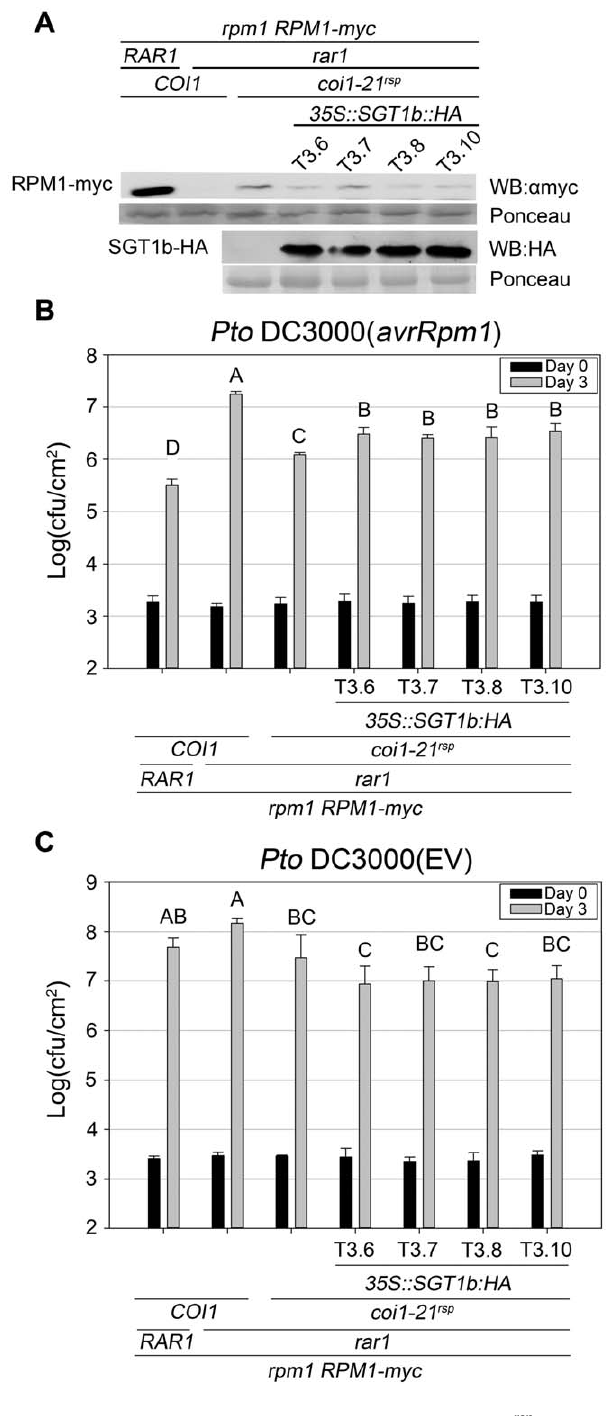
Figure 6. SGT1b over-expression antagonizes coi1 rsp -depen- dent RPM1 accumulation and RPM1 -mediated disease resis- tance in rar1 . (A) Western blot analysis of RPM1-myc and SGT1b-HA protein levels in indicated genotypes. RuBisCo levels stained by Ponceau S serve as loading control. The result displayed is one of three independent blots giving similar results. (B–C) Bacterial growth analysis of Pto DC3000( avrRpm1 ) (B) and Pto DC3000(EV) (C). Bacteria were hand-infiltrated into leaves of each indicated genotype and counted at day 0 and day 3. Error bars represent 2 6 SE. Pair-wise comparisons for all means for bacterial growth on day 3 were performed with One-Way ANOVA test followed by Tukey-Kramer HSD at 95% confidence limits. The bacterial growth assays were